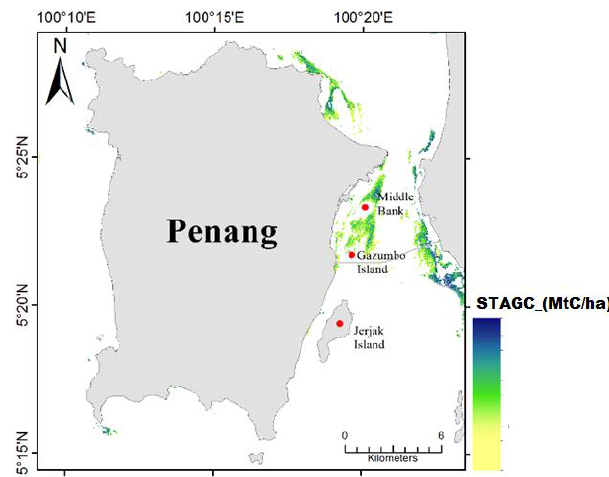
Figure 6. The total aboveground seagrass blue carbon spatial extent in Penang